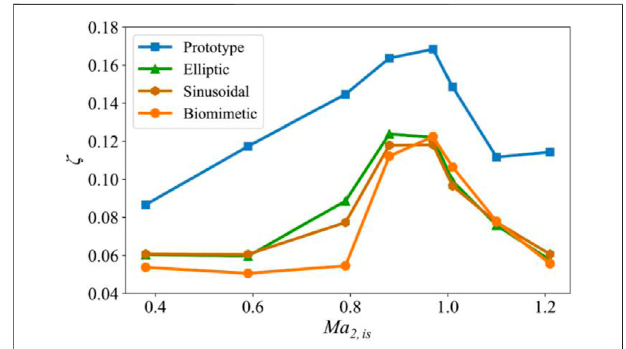
FIGURE 8 | The relationship between the energy loss coef fi cient of the four blades and the outlet isentropic Mach number.